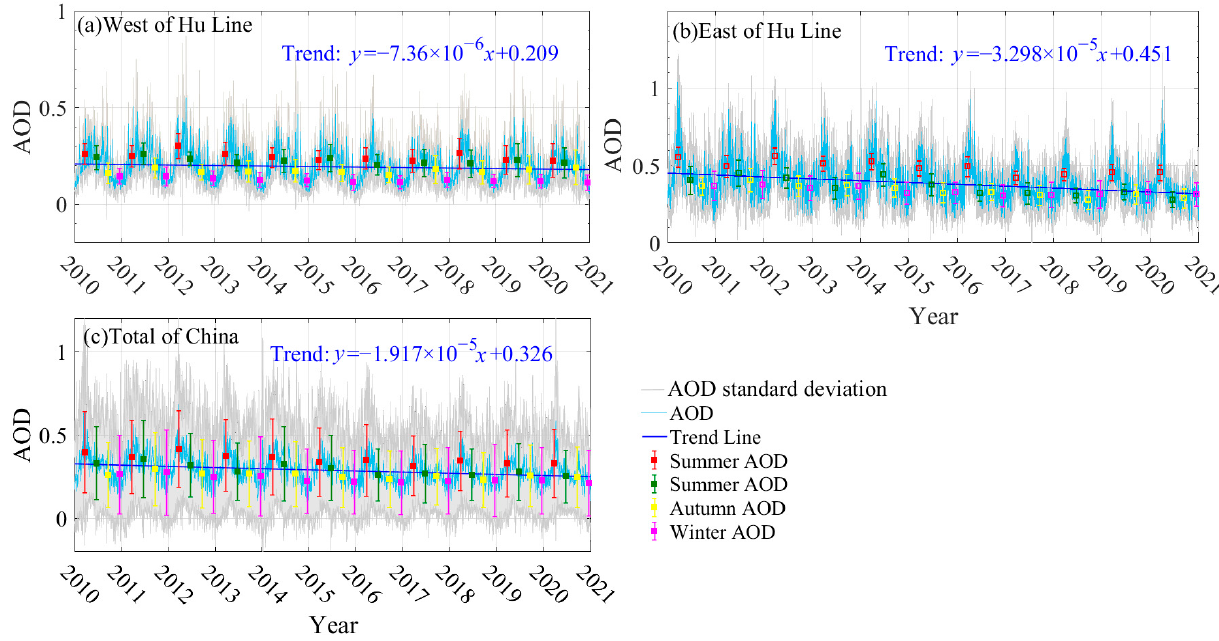
Figure 7. Daily average and standard deviations of AOD values from 2010 to 2020 in the Eastern and Western regions of the Hu Line.